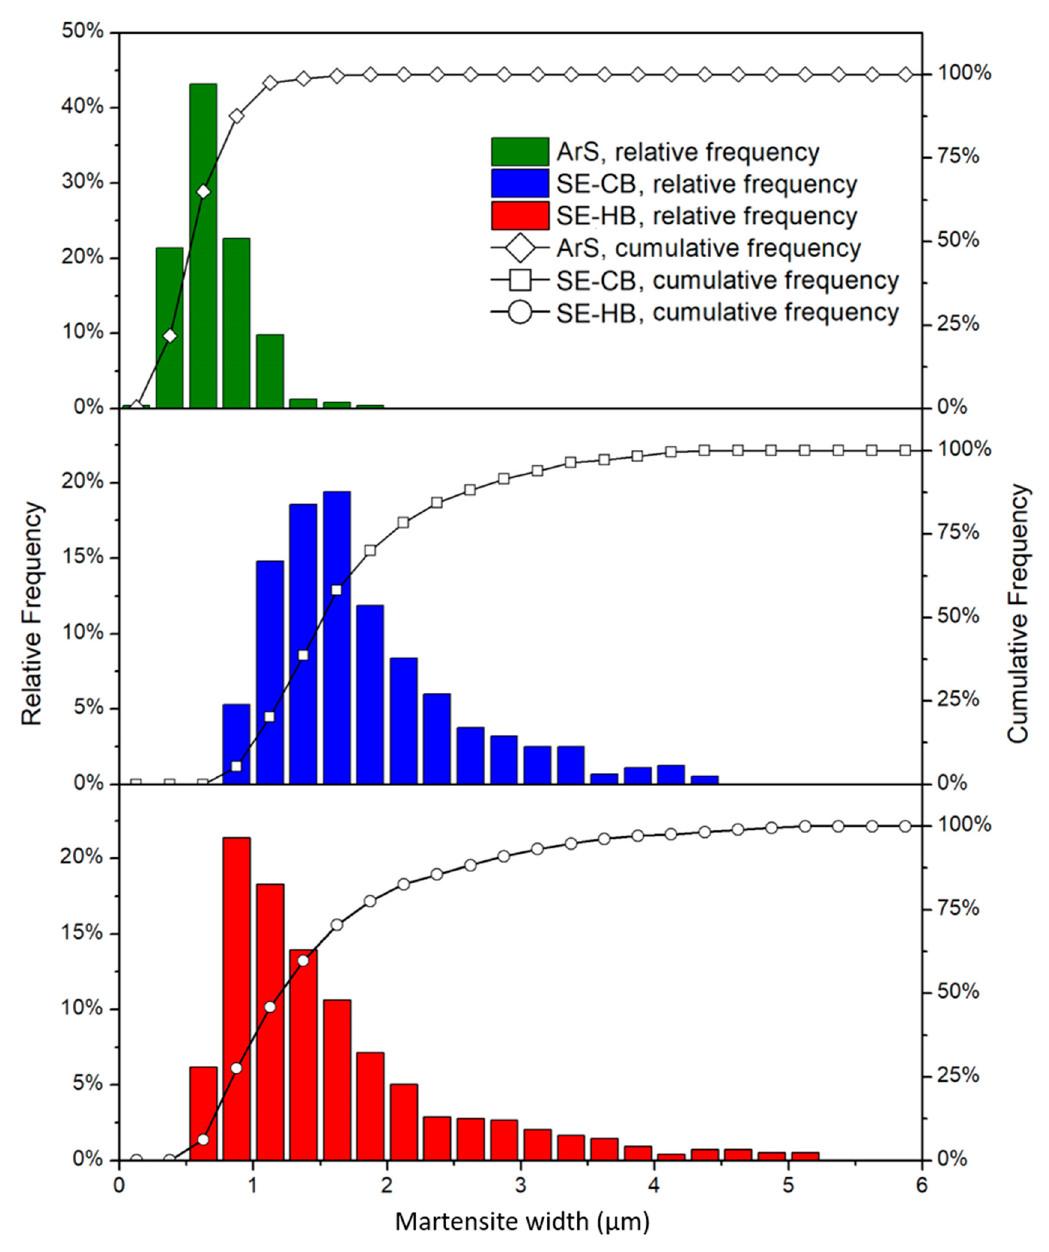
Figure 7. Martensite width relative and cumulative frequency distribution for all the deposition conditions